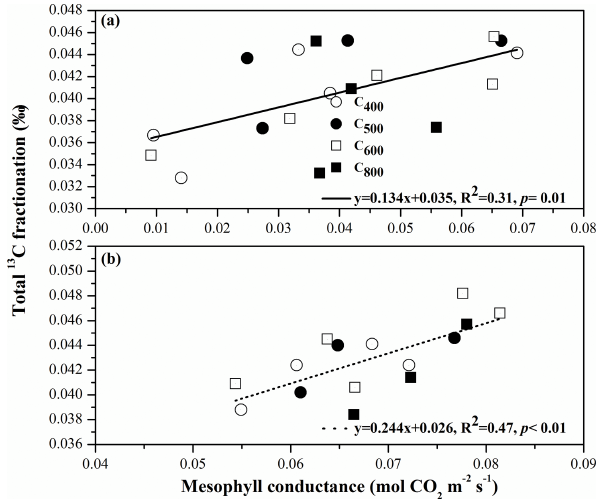
Figure 8. Regressions between mesophyll conductance and total 13 C fractionation in P. orientalis (a) and Q. variabilis (b) for four CO 2 concentration × five soil volumetric water content treatments ( p ≤ 0.01, n =